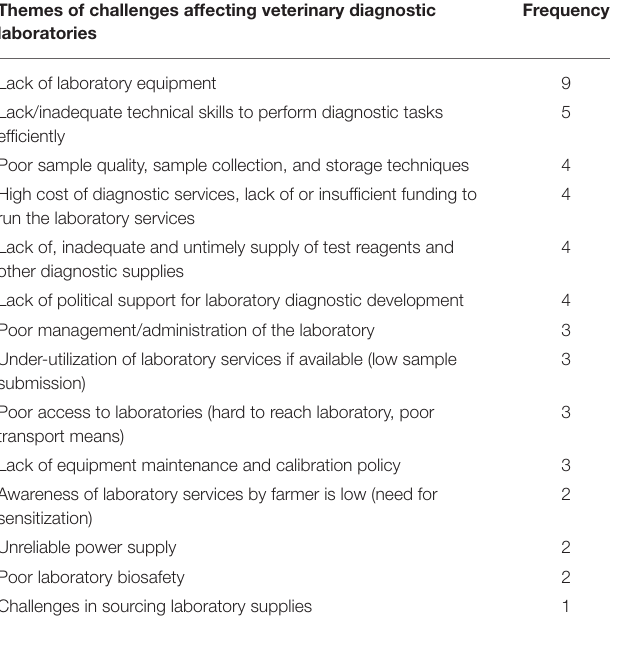
TABLE 2 | The challenges that affect the ability to use or offer diagnostic services as reported by laboratory personnel ( n =